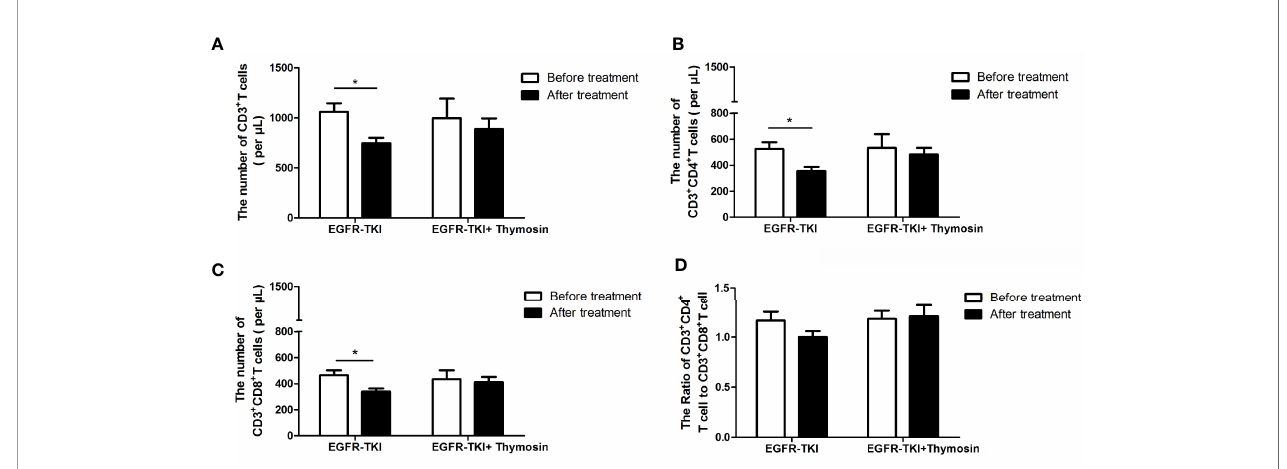
FIGURE 4 | The numbers of T cell subsets in peripheral blood in EGFR-TKI group and EGFR-TKI plus thymosin group before and after treatment. (A) The numbers of CD3 + T cells. (B) The numbers of CD3 + CD4 + T cells. (C) The numbers of CD3 + CD8 + T cells. (D) The ratio of CD3 + CD4 + T cells to CD3 + CD8 + T cells. * P <